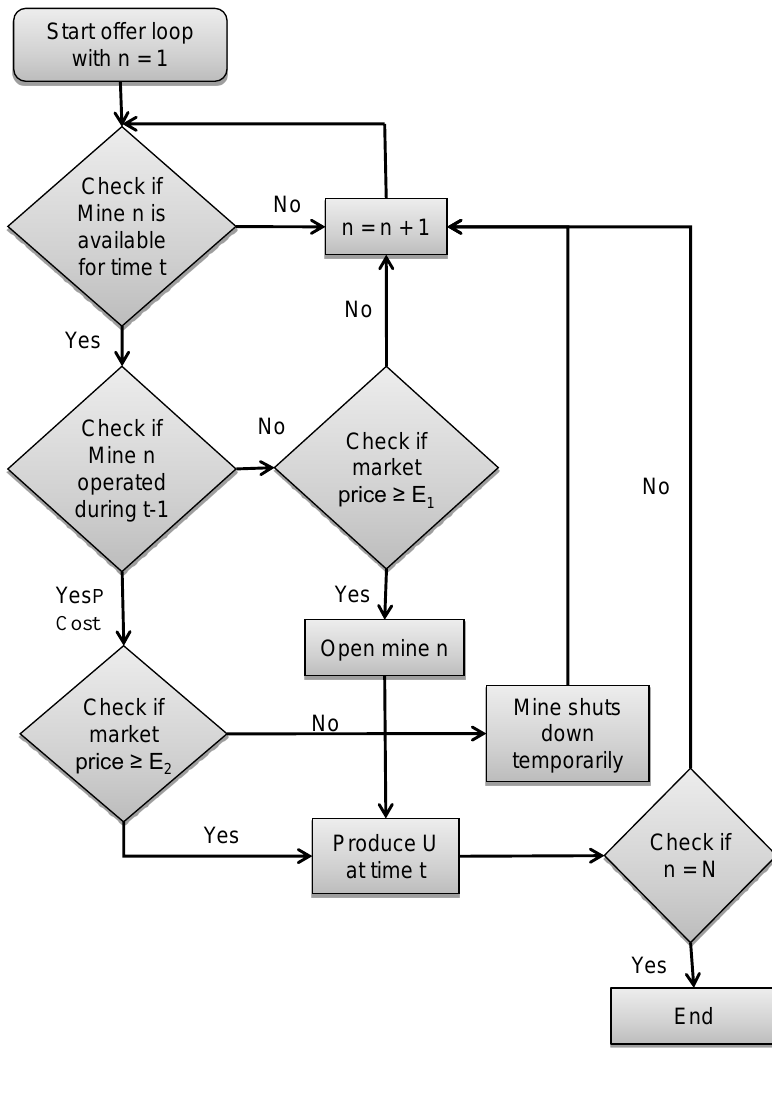
Figure 4. Uranium mine decision making event